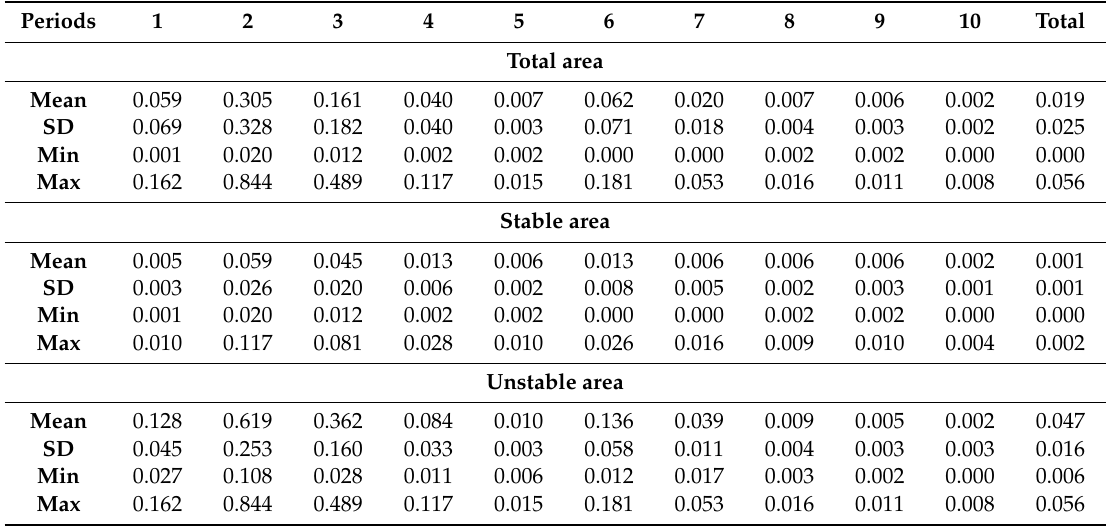
Table 6. Horizontal displacement rates (in m / month) of monitoring points in the di ff erent periods.